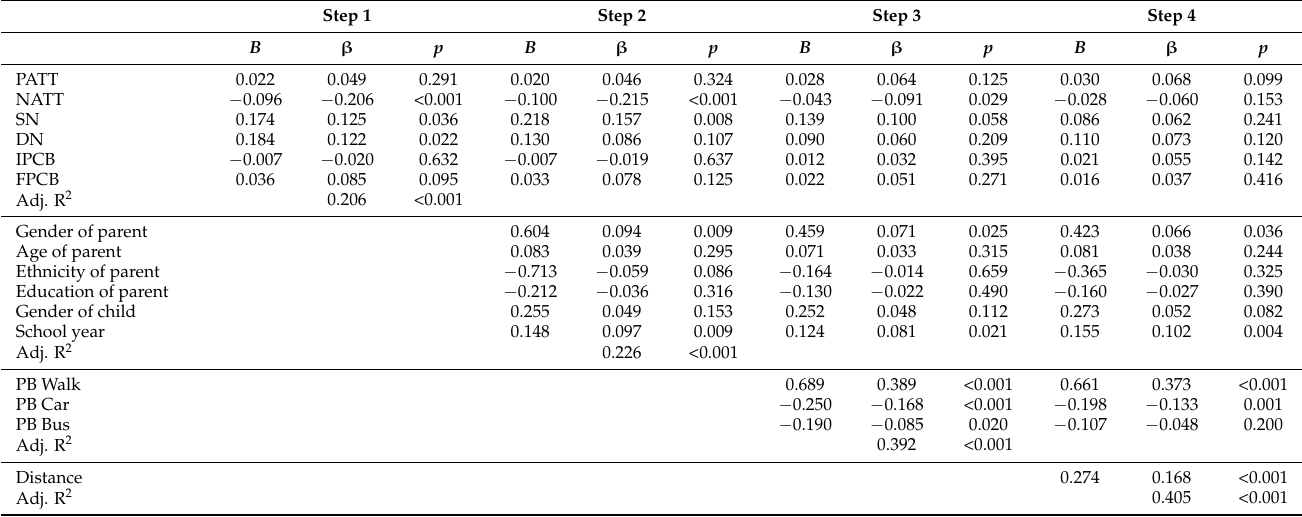
Table 6. Parents’ intention to let the child walk to school. Hierarchical linear regression